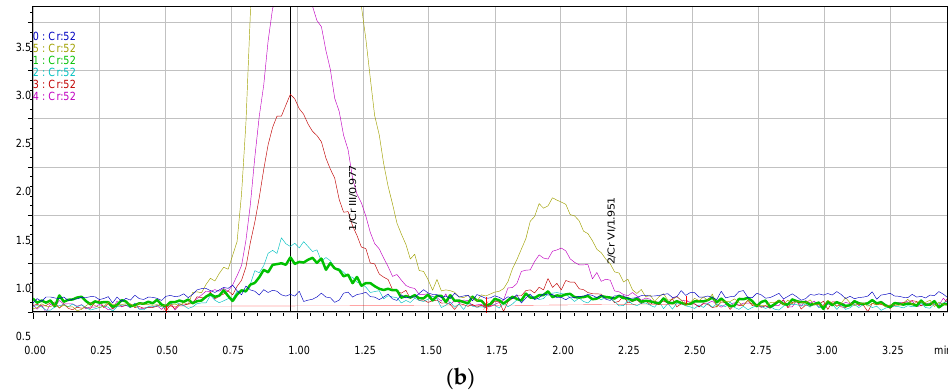
Figure 1. ( a ) Overlaid chromatograms for HPLC-ICP-MS with the use of Hamilton PRPX-100 analytical column. ( b ) Overlaid chromatograms for HPLC-ICP-MS with the use of Bio Wax analytical column.